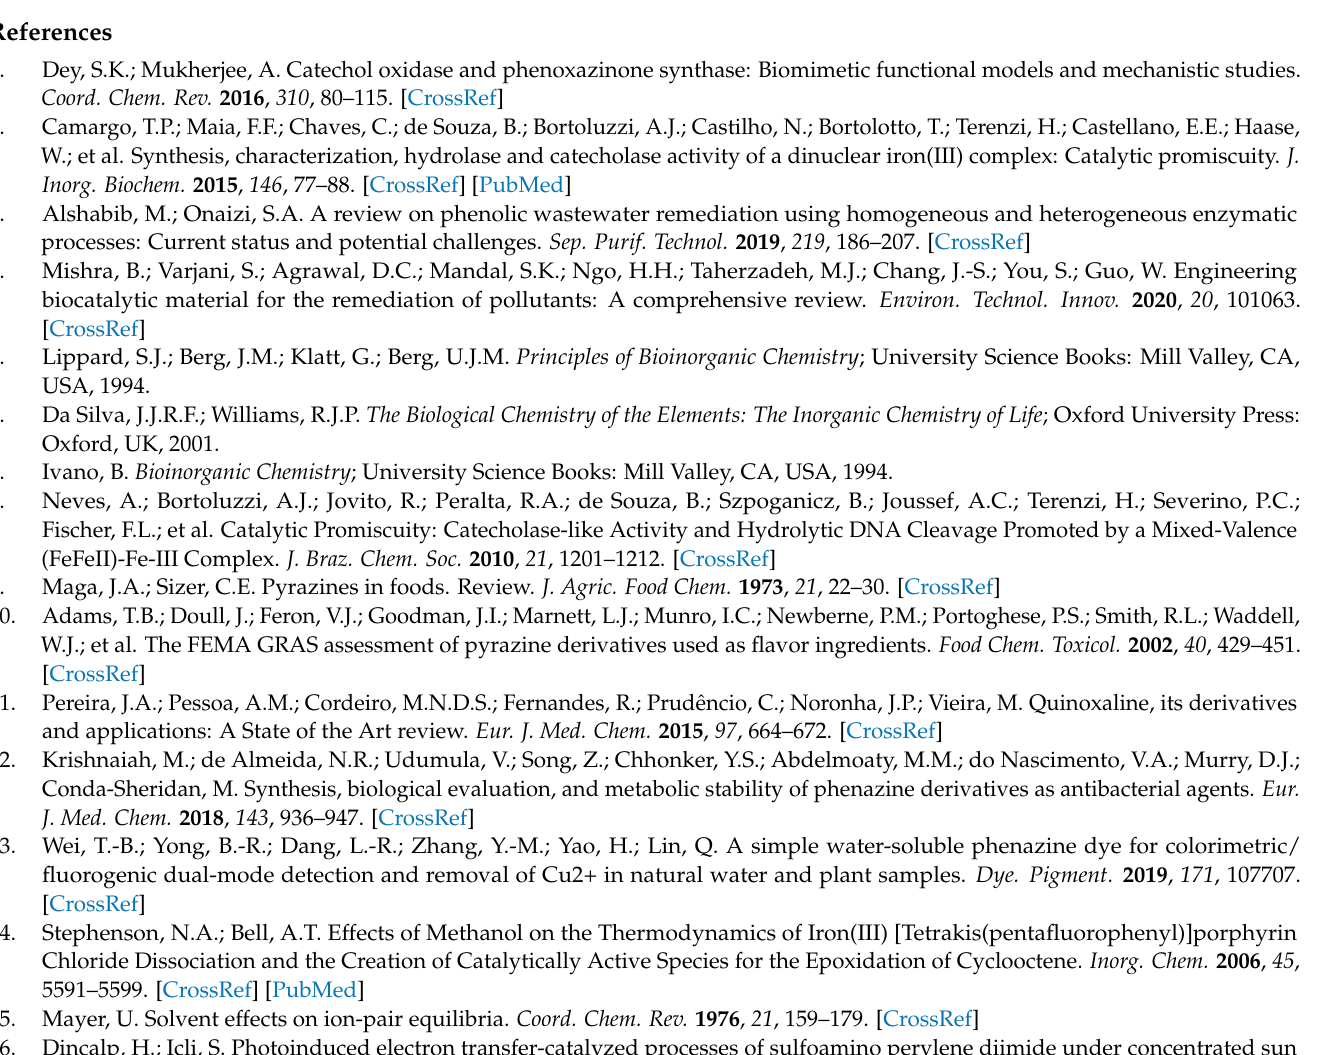
Figure S7: Far-infrared spectra of the different iron (III) complexes obtained in this study, Figure S8: Mid-infrared spectra of the different iron (III) complexes obtained in this study and Figure S9: Typical oxidation reaction of the 3,5-di-tert-butyl catechol (DTBC) to 3,5-di-tert-butyl- o - benzoquinone (DTBQ) monitored at 400